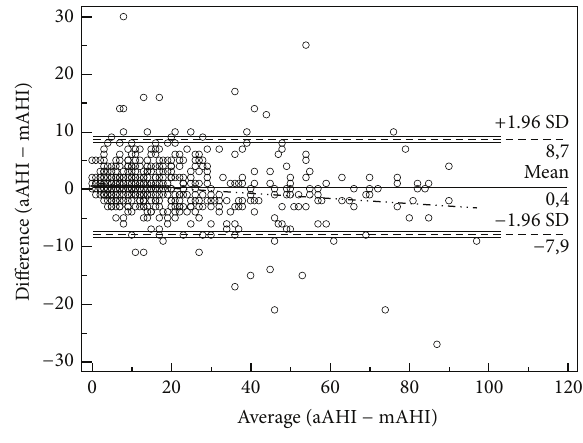
Figure 2: The distribution of both mAHI and aAHI.